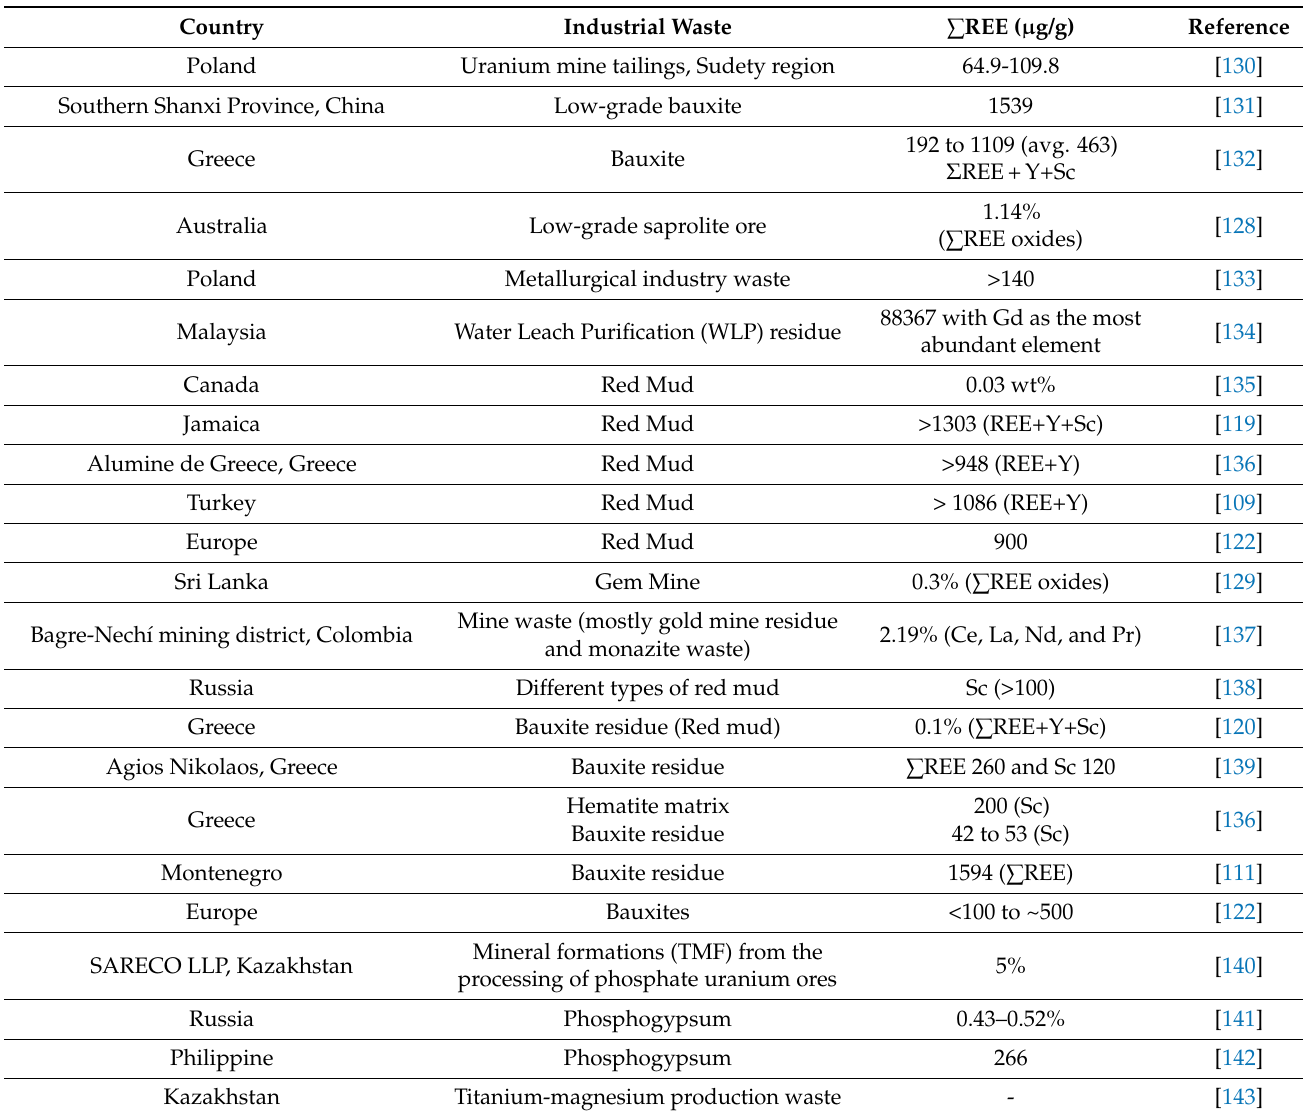
Table 6. Concentrations of REE in mine tailings and mine waste of different mines, industrial materials, and industrial